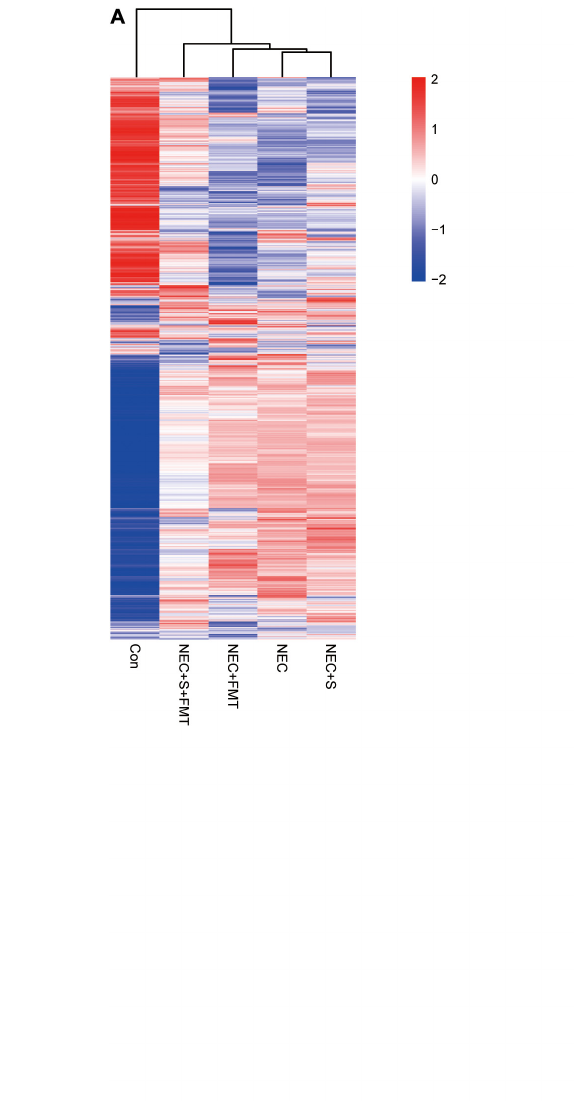
feces and breast milk but does not exist in the gut of NEC